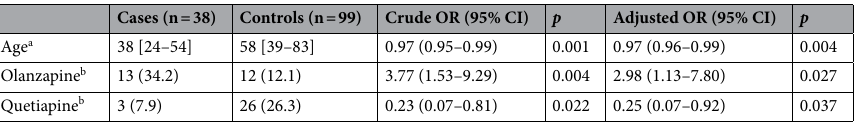
Table 2. Risk factors for antipsychotic-induced weight gain. a Median [IQR]. b As compared with the other